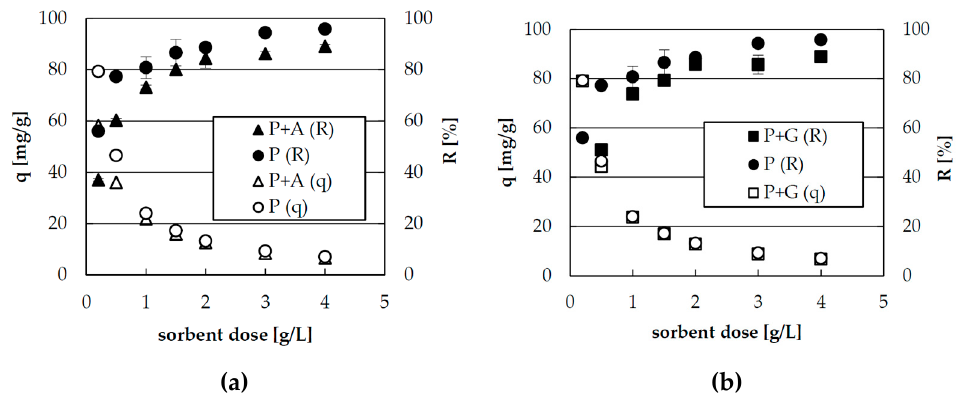
Figure 1. The effect of the sorbent dose on zinc(II) ions sorption on pectin based biosorbents: ( a ) hybrid pectin biosorbent with agar (P+A); and ( b ) hybrid pectin biosorbent with guar gum (P + G). (R) percentage of zinc removal [%], (q) sorption capacity [mg/g].